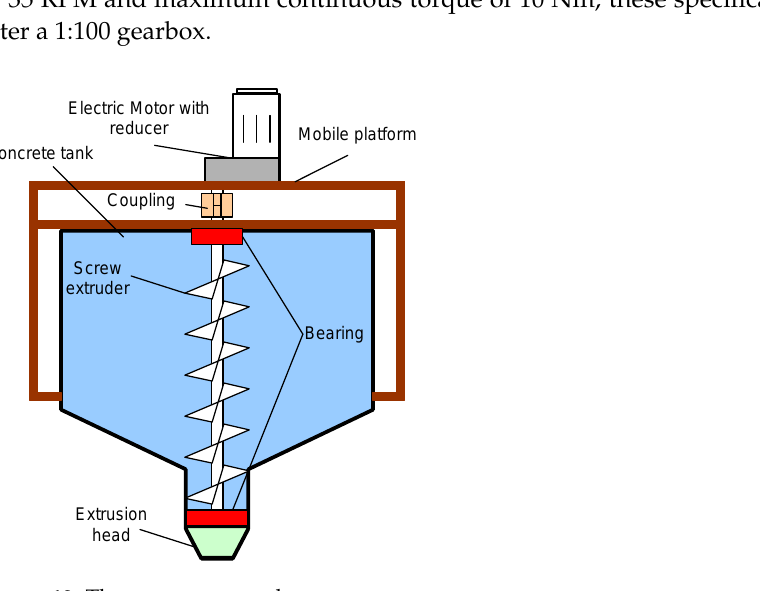
Figure 10. The concrete